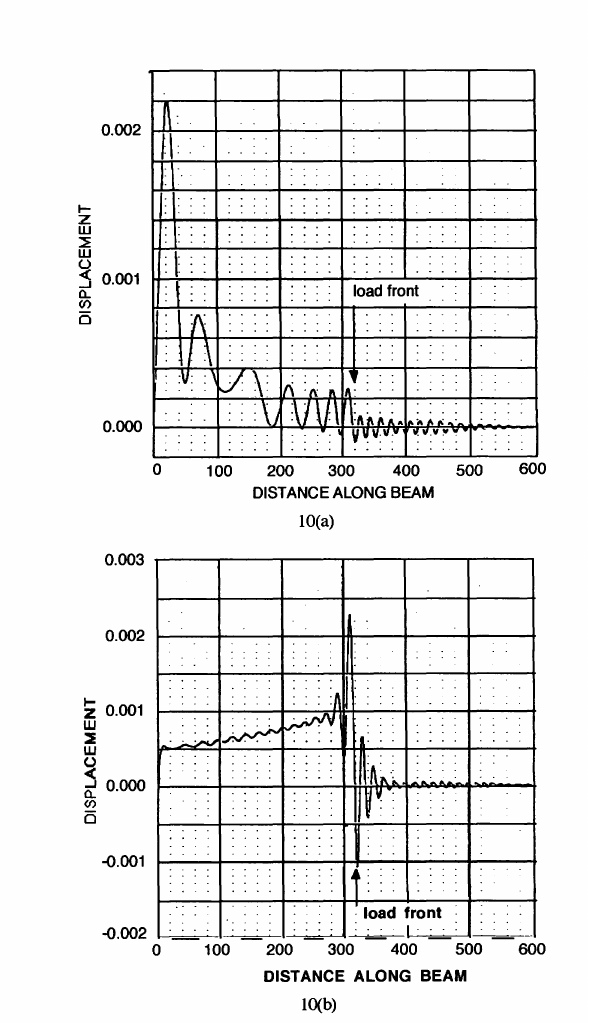
FIGURE 10 Step pressure load moving along a beam on an elastic foundation of varying foundation modu lus. This is the behavior of a conical shell subject to a blast wave in the surrounding air traveling along the axis. In (a) the load is moving from the soft to the stiff region, i.e., from the big end to the small end of the cone; in (b) the load is moving from the stiff to the soft region. (Computations from P.